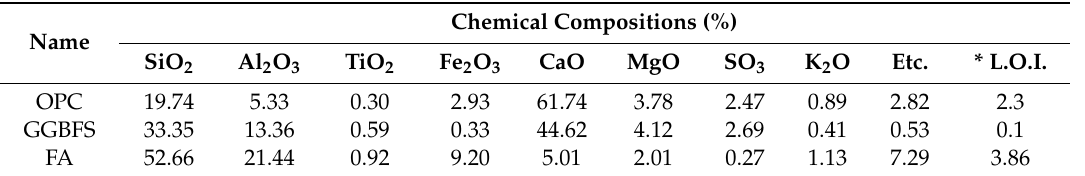
Table 1. Chemical compositions of cement and